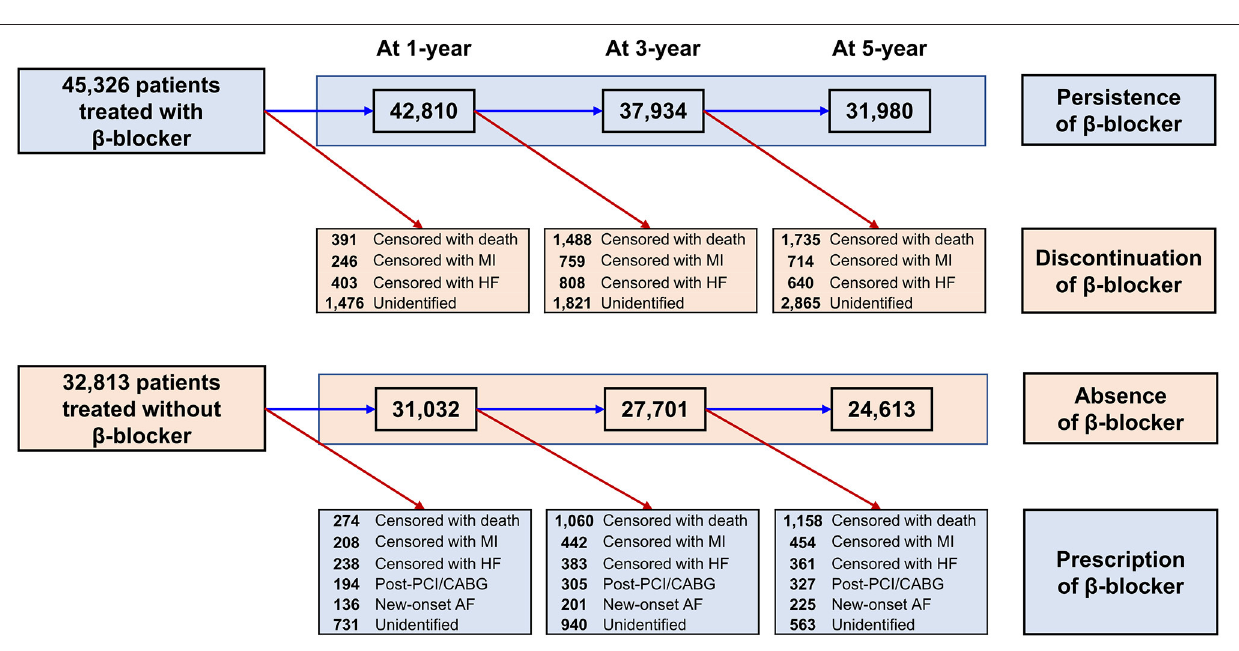
FIGURE 4 | Temporal trends in change of beta-blocker prescription. AF, atrial fibrillation; CABG, coronary artery bypass graft surgery; HF, heart failure; MI, myocardial infarction; PCI, percutaneous coronary